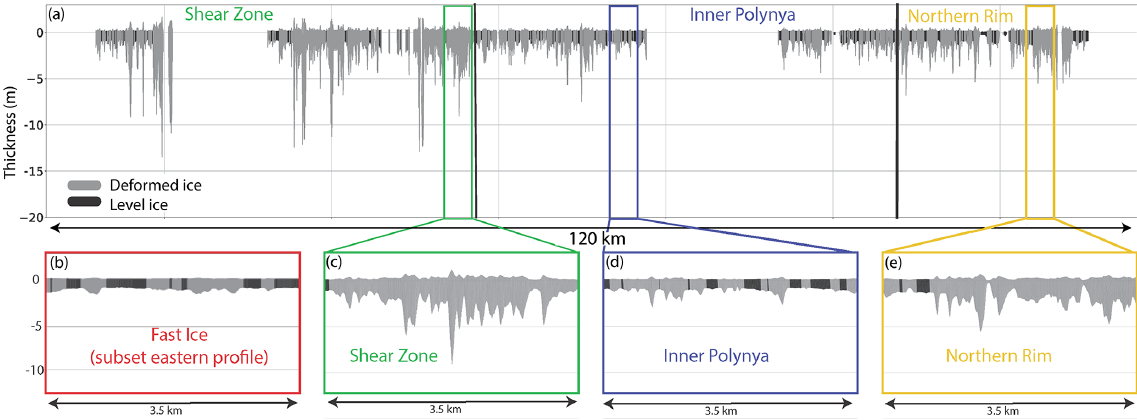
Figure 6. Ice thickness profile of the northern profile. The black and gray colors distinguish between level and deformed ice. Four subsets, representative of the four thickness zones, are displayed in (b) – (e) . The locations of the subsets (c) – (e) are indicated in (a) . The Fast Ice zone is present in the first kilometers off the coast of all profiles but extends only on the eastern profile for more than 8km (see Fig. 1). Note the different degrees of deformation in the four zones, depicted by the areal fraction of level ice and the total thickness of the ridges. For the eastern and central profiles, see